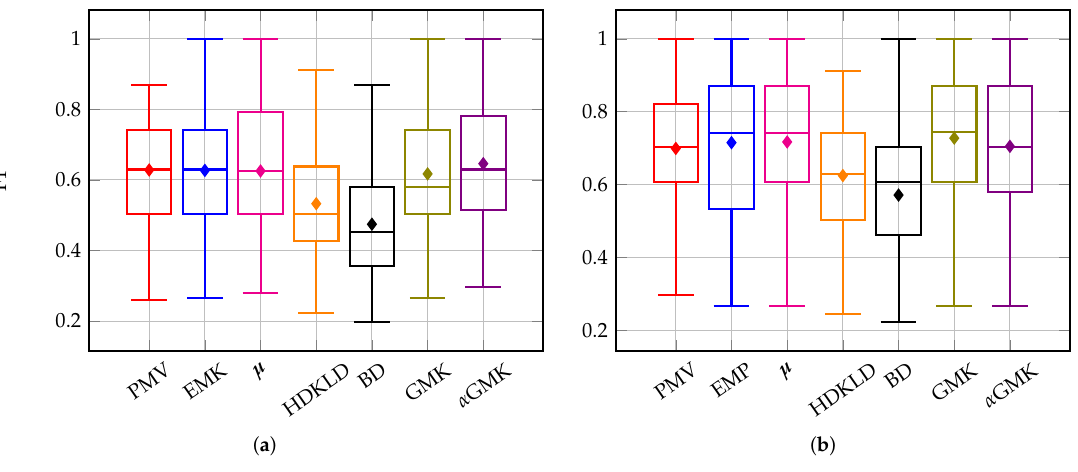
Figure 10. Boxplot of F1 score repartitions for classification of management practices using time series of year ( a ) 2013 and ( b ) 2014. The line in the box stands for the median whereas the dot stands for the mean.